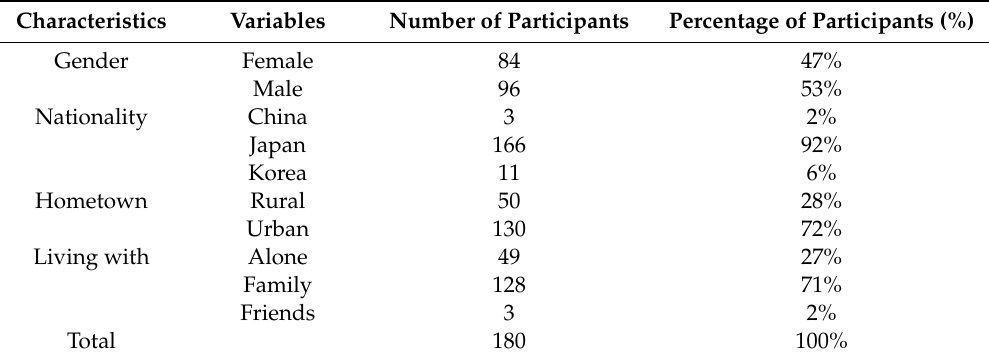
Table 2. Descriptive statistics for participants’ demographics.